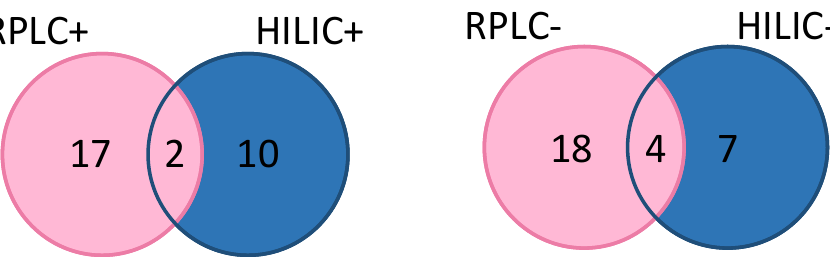
Figure 2. Venn diagram showing the number of features detected according to the analytical method used. RPLC+: reversed-phase liquid chromatography coupled to mass spectrometry used in positive ionization mode; RPLC − : reversed-phase liquid chromatography coupled to mass spectrometry used in negative ionization mode; HILIC+: hydrophilic interaction liquid chromatography coupled to mass spectrometry used in positive ionization mode; HILIC − : hydrophilic interaction liquid chromatography coupled to mass spectrometry used in negative ionization mode.